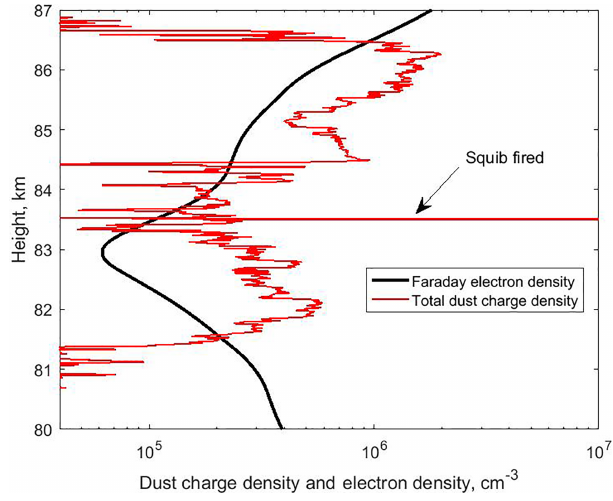
Figure 7. Electron density measured with the Faraday instrument, and the total dust charge density as observed by DUSTY, on MXD-